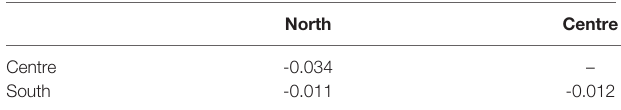
TABLE 4 | Pairwise FST values among samples of Rhopilema nomadica in three locations the coast of Israel (p>0.05).